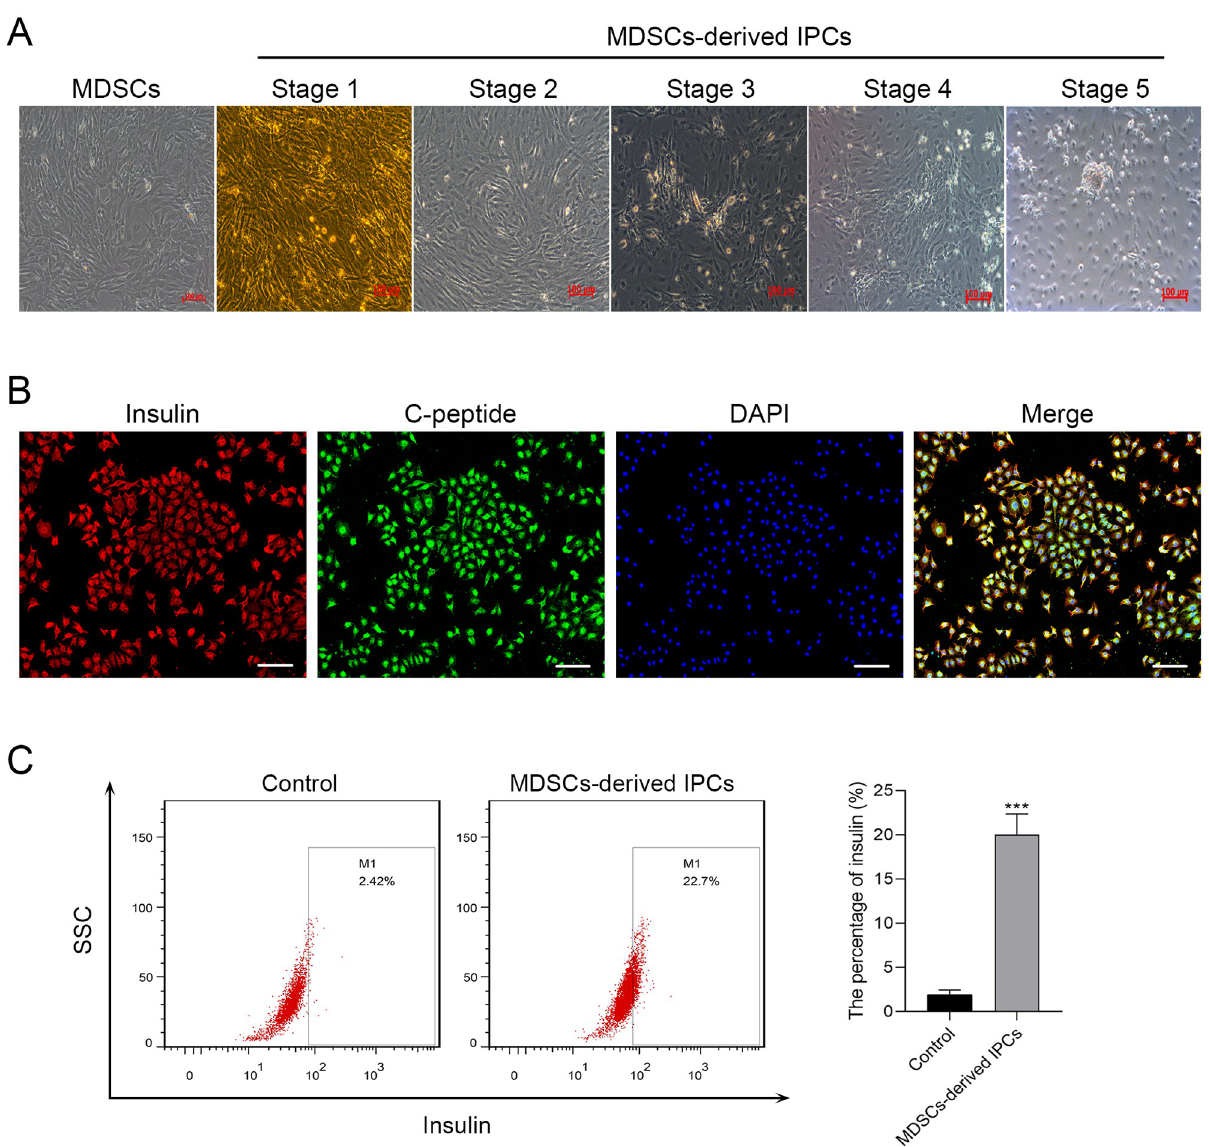
Fig 2. The differentiation of MDSCs into IPCs in vitro . (A) Morphologies of MDSCs-derived IPCs during stage 1–5 of differentiation. Scale bar is 100 μ m. (B) MDSCs-derived IPCs at stage 5 were identified via co-immunostaining of insulin (red) and C-peptide (green). Nuclear DAPI staining was presented in blue. Scale bar is 200 μ m. (C) The percentage of insulin in MDSCs-derived IPCs was measured using flow cytometry. ��� P < 0.001 compared with the